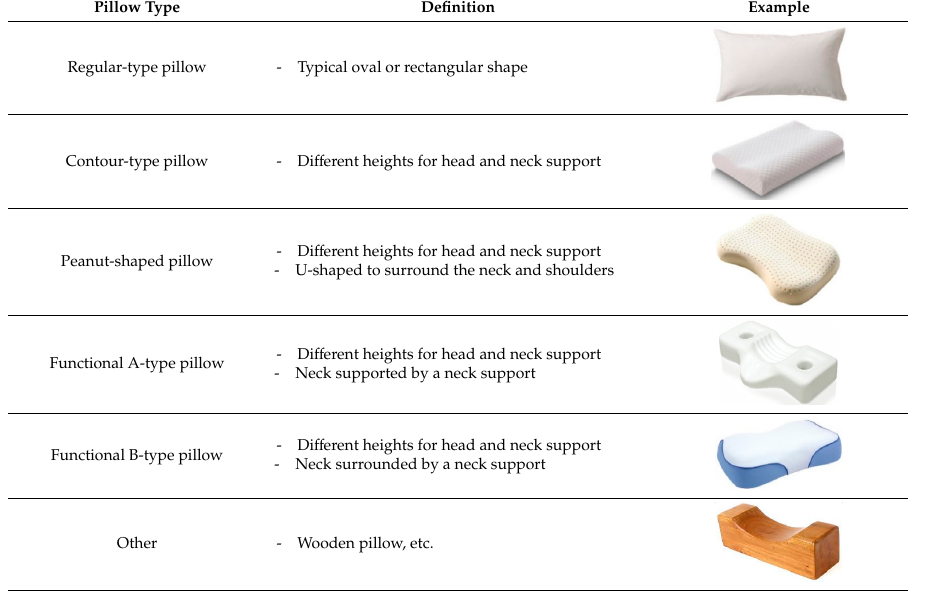
Table 2. Classification and definition of pillow types.